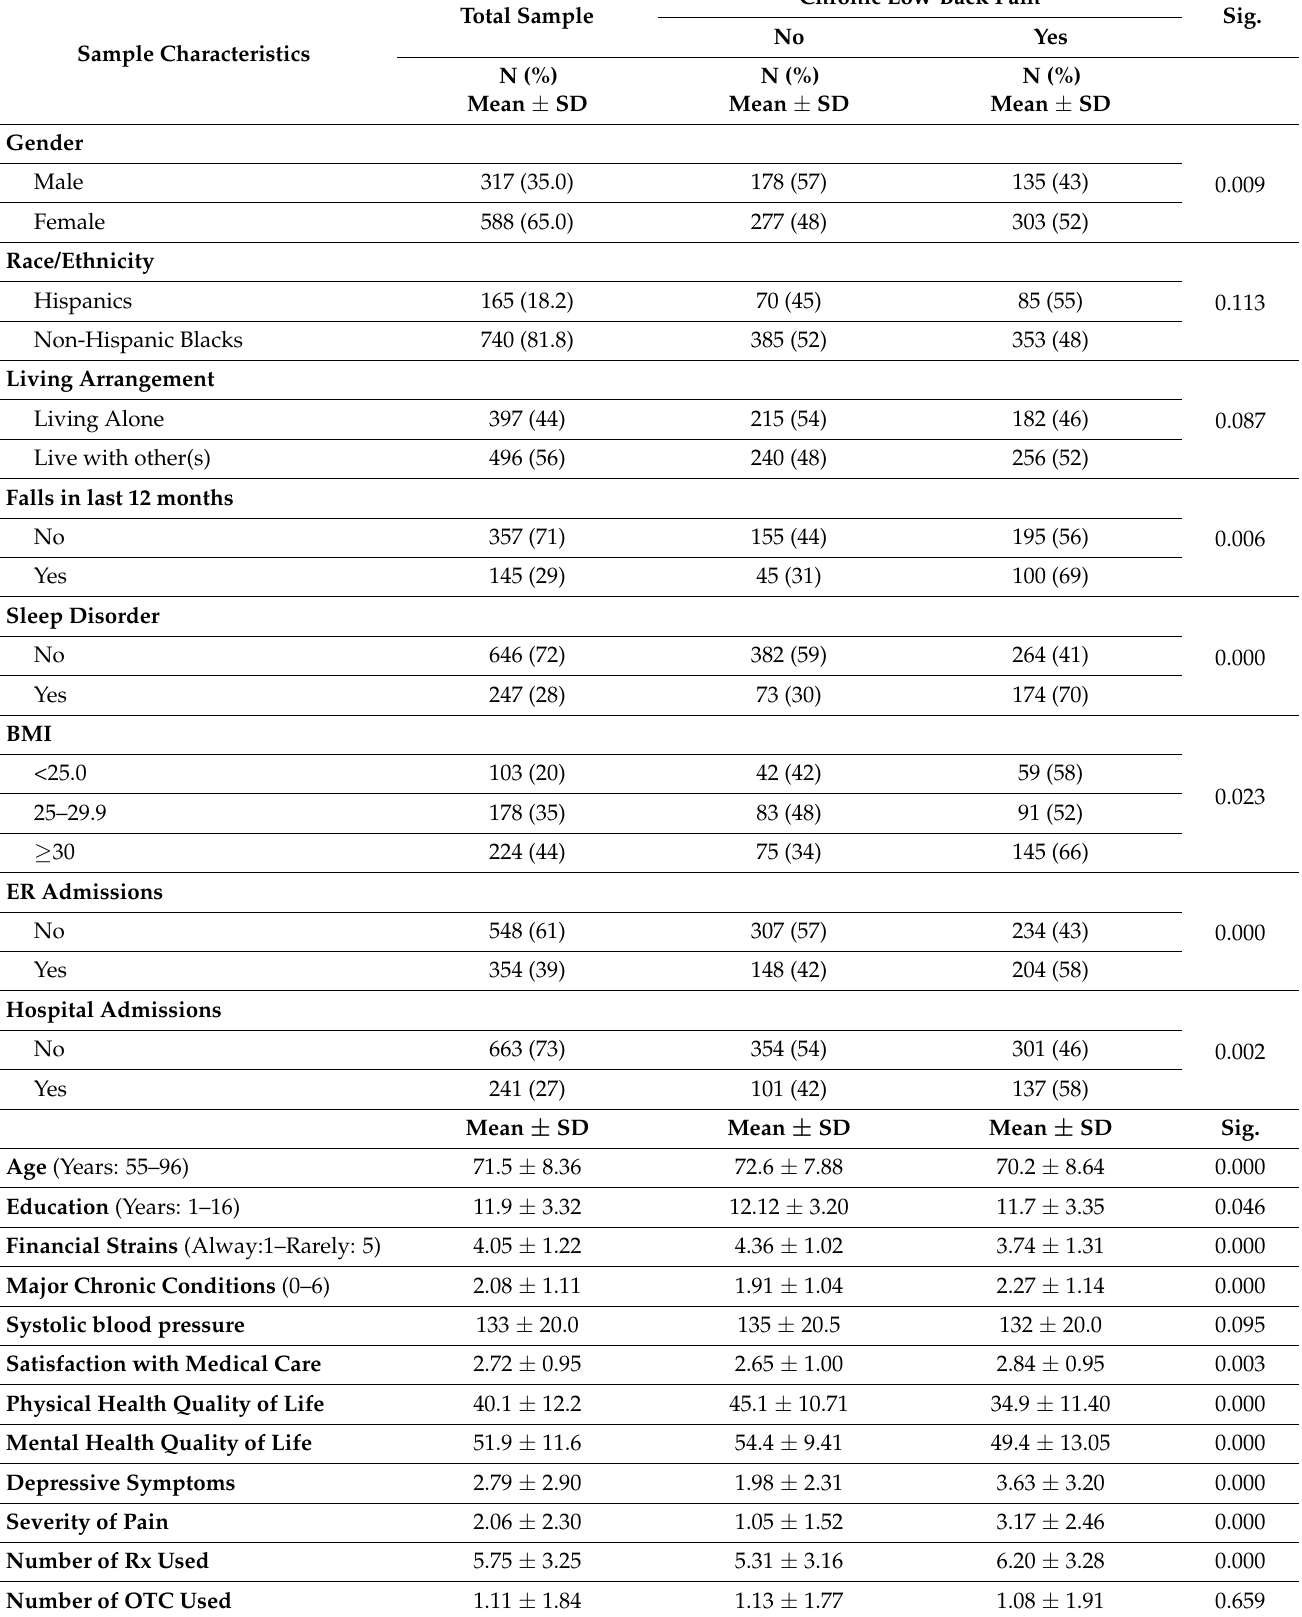
Table 1. Characteristic of sample a bivariate associations between chronic low back pain and other related outcomes (n = 905).